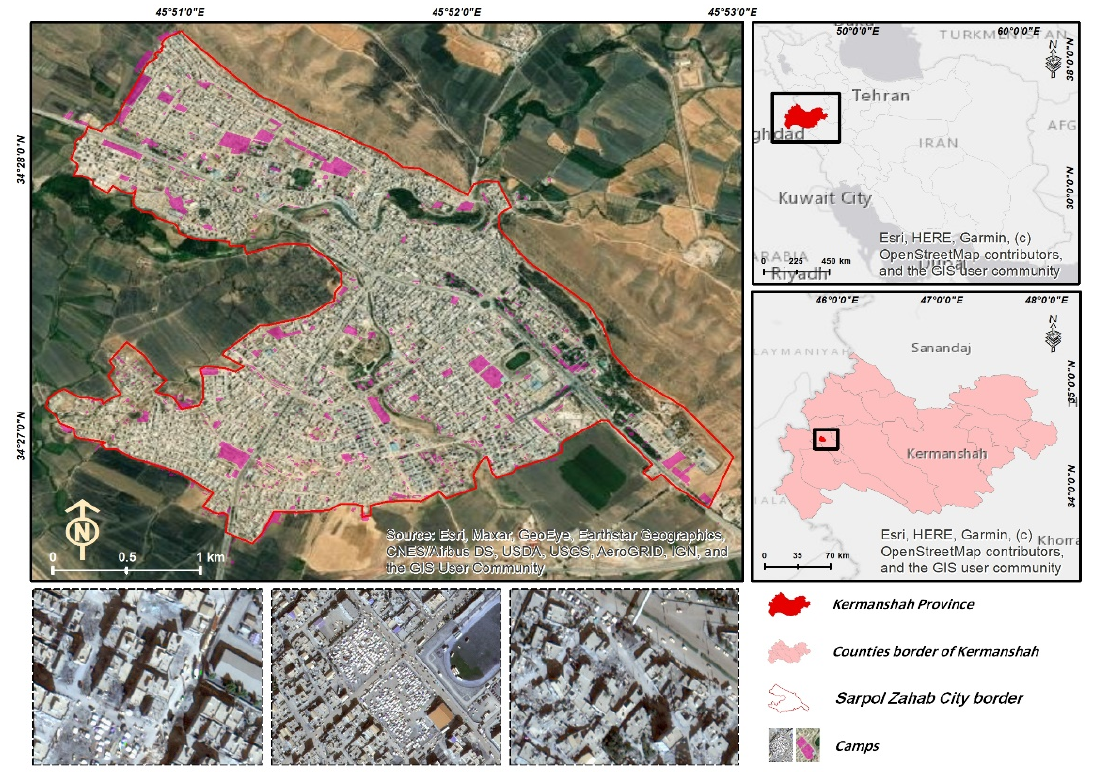
Figure 1. Location of Sarpol-e Zahab city and Kermanshah province in west Iran.